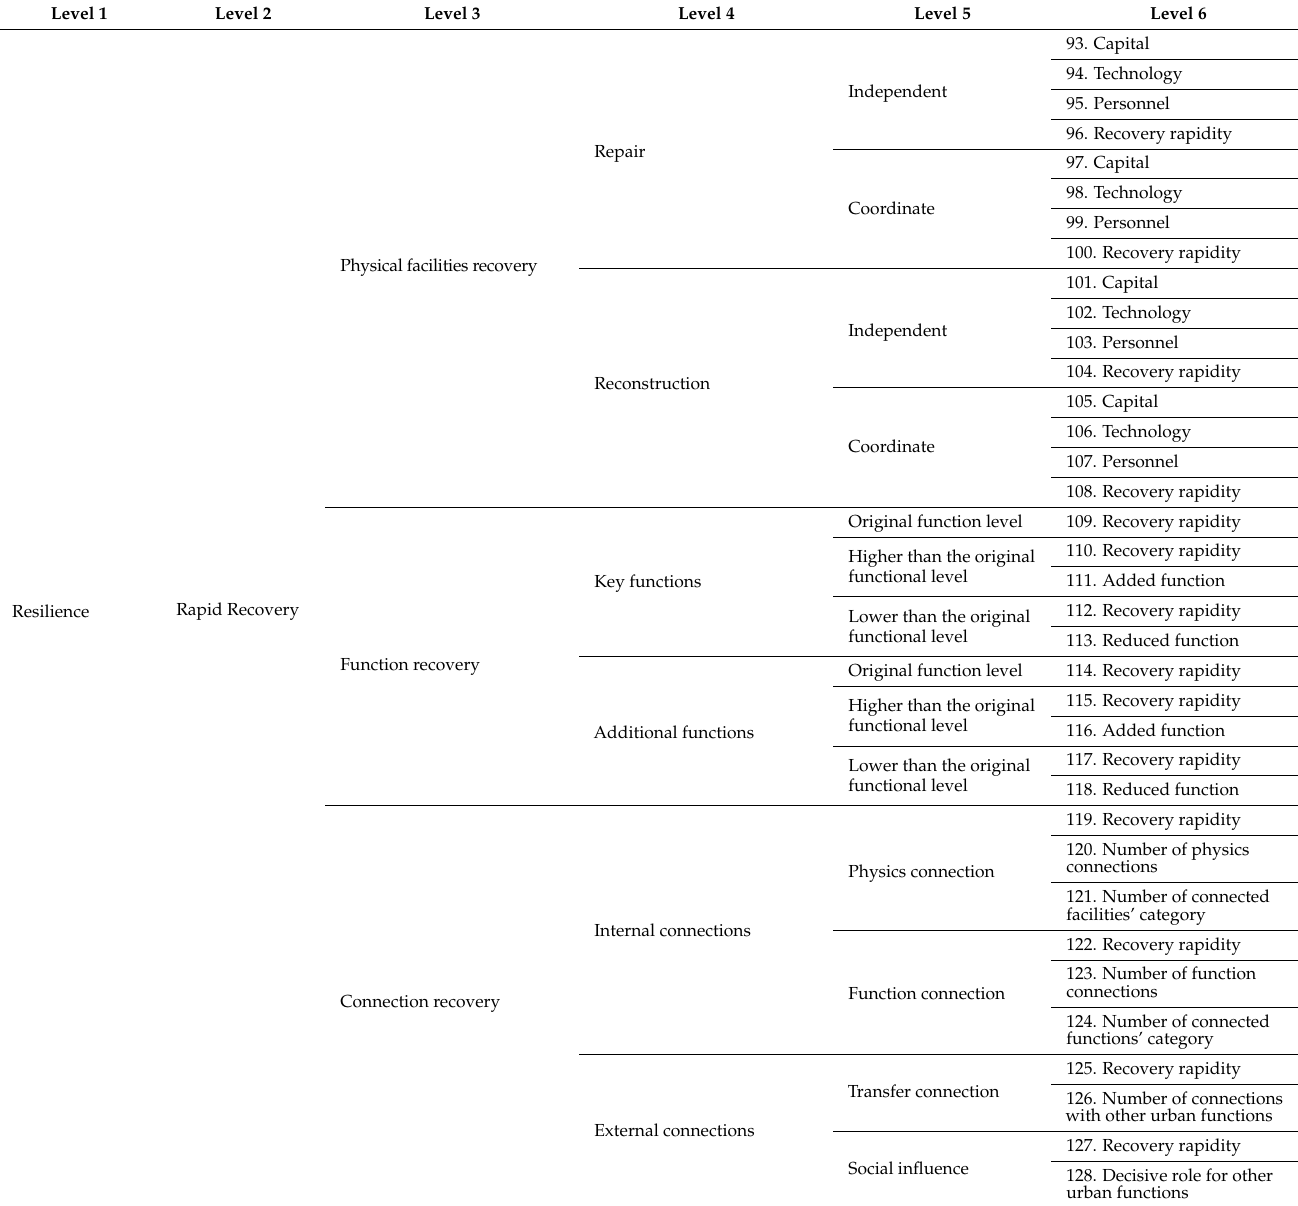
Table A2. Resilience indicators of rapid